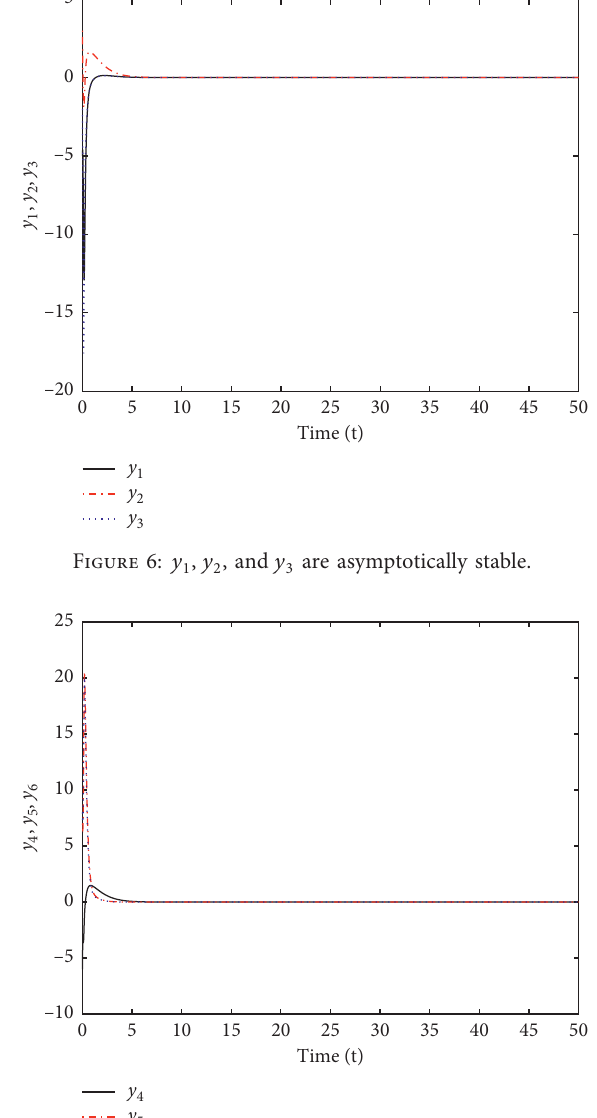
,y , and y are asymptotically stable. 4 5 6